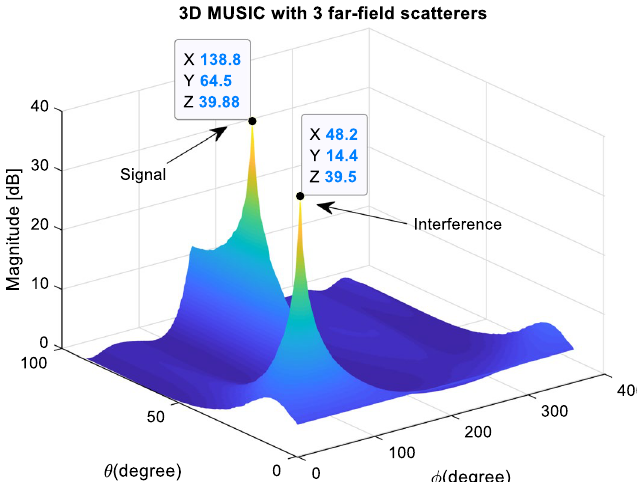
Fig. 8 MUSIC Pseudospectrum function in presence of three far-field scatterers for one incident signal and one